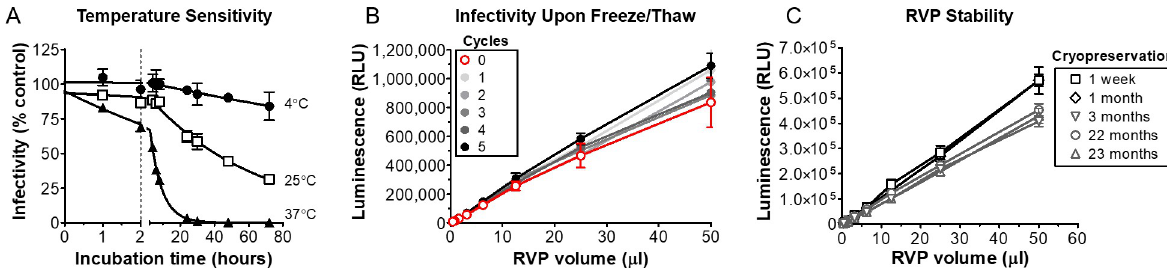
Fig 3. ZIKV RVPs are infectious and stable under commonly used conditions. (A) Cryopreserved ZIKV RVP aliquots were thawed, mixed, incubated at 4, 25, or 37˚C, and used to infect BHK-DC-SIGN cells. Infectivity was compared to that of freshly thawed ZIKV RVPs. Each data point is the mean of 3 replicate wells. (B) Infectivity of ZIKV RVPs sampled immediately after production or after multiple freeze/thaw cycles. Each data point represents the mean of at least 4 replicate wells. RVP infectivity did not diminish upon freeze/thaw when tested from 0 to 5 cycles. (C) Five different lots of ZIKV RVPs (produced at various times over 23 months) were tested for infectivity using BHK-DC-SIGN target cells. RVPs were added to 96-well black plates and subjected to serial, 2-fold dilutions before adding target cells. Each data point is the mean of 8 replicate wells. All error bars represent SD.